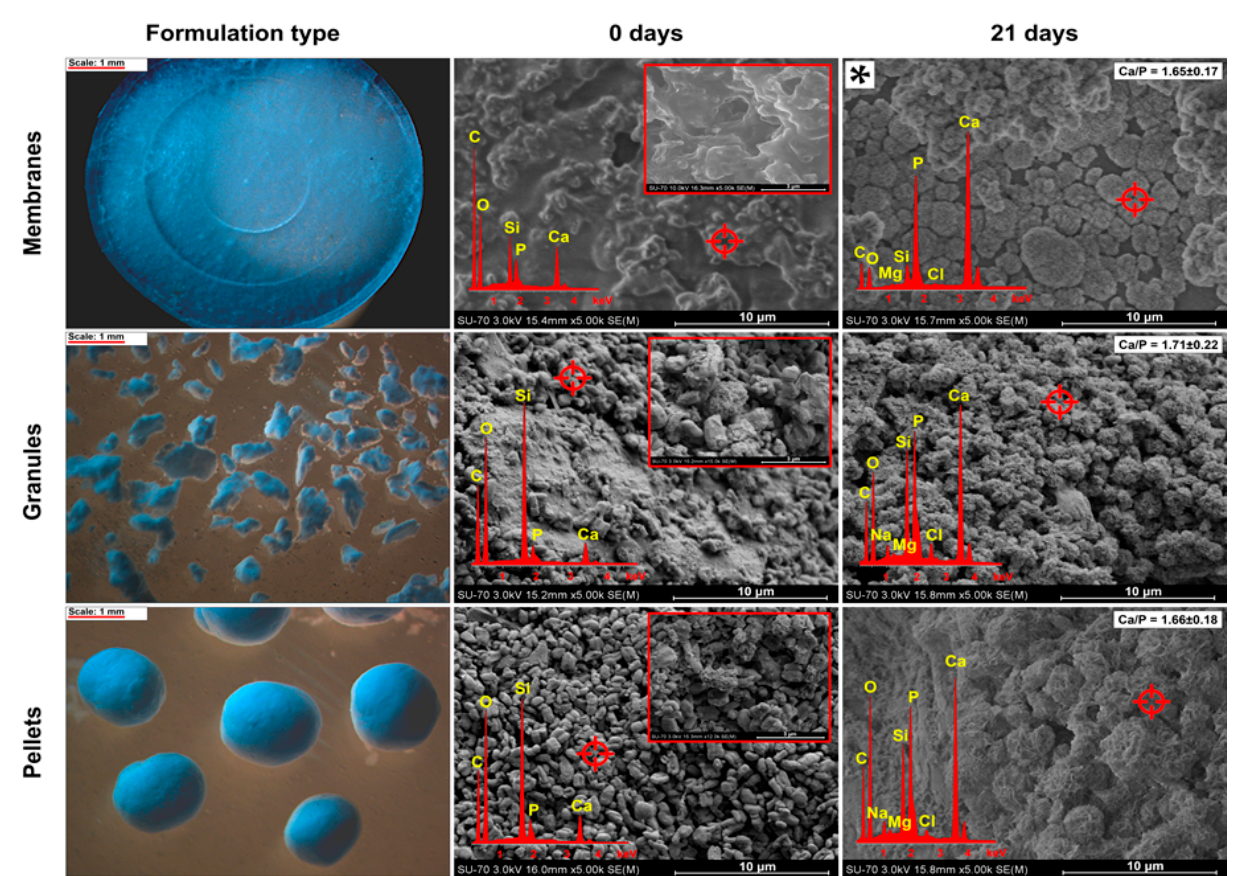
Figure 4. Stereoscopic and SEM-EDX micrographs of obtained pharmaceutical forms before and after 21 days of incubation in simulated body fluid. * The micrograph of sample subjected to additional rapid coating procedure before 21-day incubation in simulated body fluid.